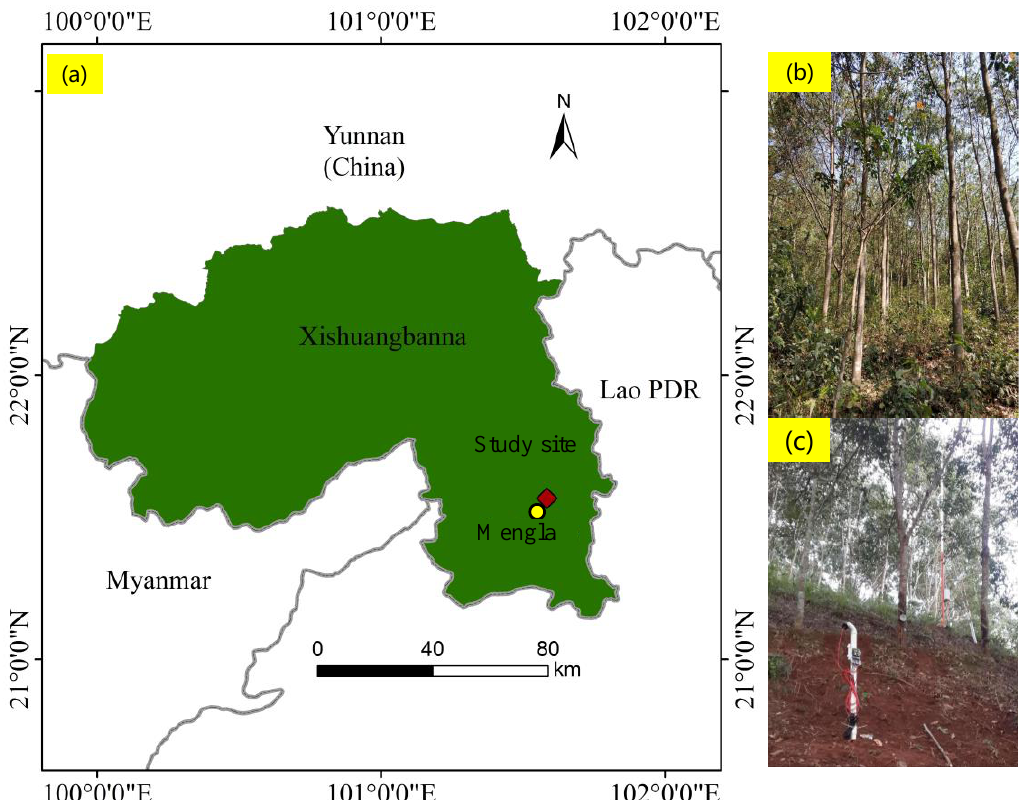
Figure 1. The experimental site of a rubber plantation (indicated by a solid square; 21°34 ′ 10 ″ N, 101°35 ′ 24 ″ E) in Xishuangbanna, Yunnan Province, Southwest China. Mengla indicated by a yellow circle (21°28 ’ N, 101°35 ’ E) (( a ) Location of area; ( b ) Observed sample rubber plantation; ( c ) Automatic meteorological system stations (WS-BR06, Campbell, CA, USA) and Drain gauge G3 (METER, Pullman, WA, USA).